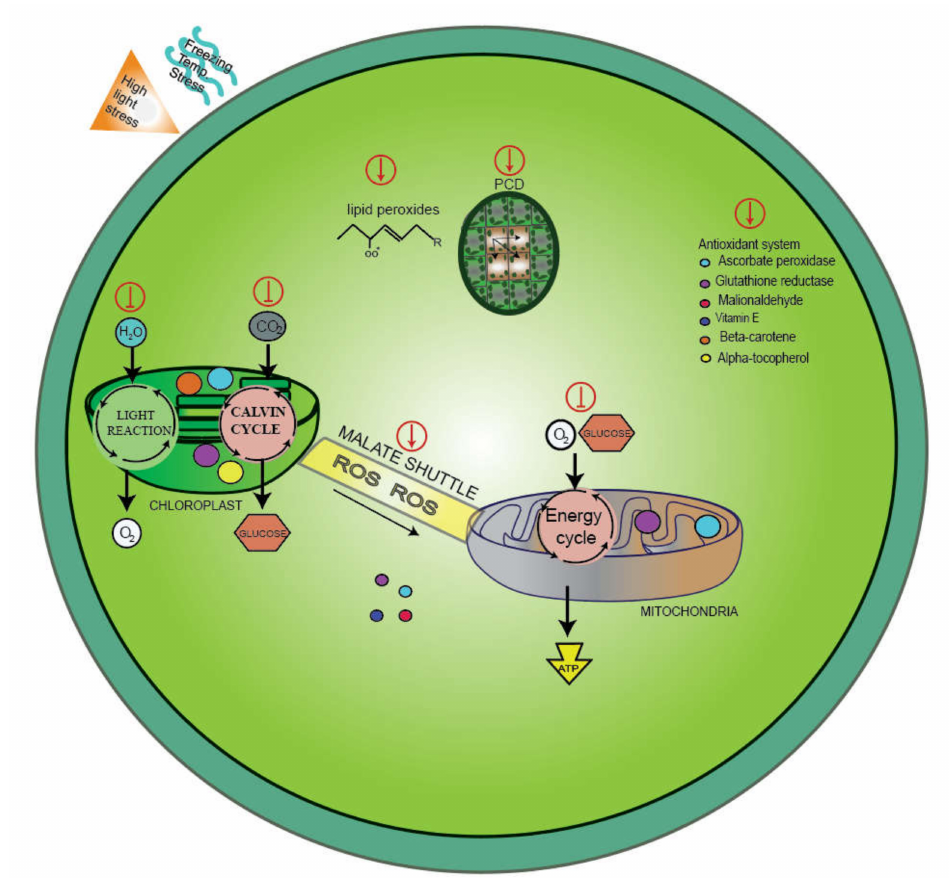
Figure 4. A diagrammatic representation of the synchronous effect of ROS, high light and cold stress inside the cell environment. As shown in figure chloroplast is the site for carbon reduction and shared energy cycle with the mitochondria. ROS accumulation leads to programmed cell death (PCD), an interesting way to escape oxidative damage. A malate shuttle between chloroplast and mitochondria stabilizes the levels of ROS. Numerous antioxidant systems prevail in the cell and are effective in scavenging